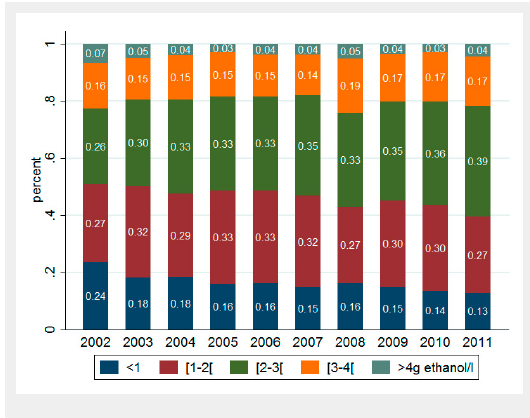
Partition of positive BAC across 5 BAC levels: ≤1, >1 to ≤2, >2 to ≤3, >3 to ≤4, >4 permille (g of ethanol per liter of blood). BAC: blood alcohol concentration Note: The percentage of subjects in each category is indicated in the